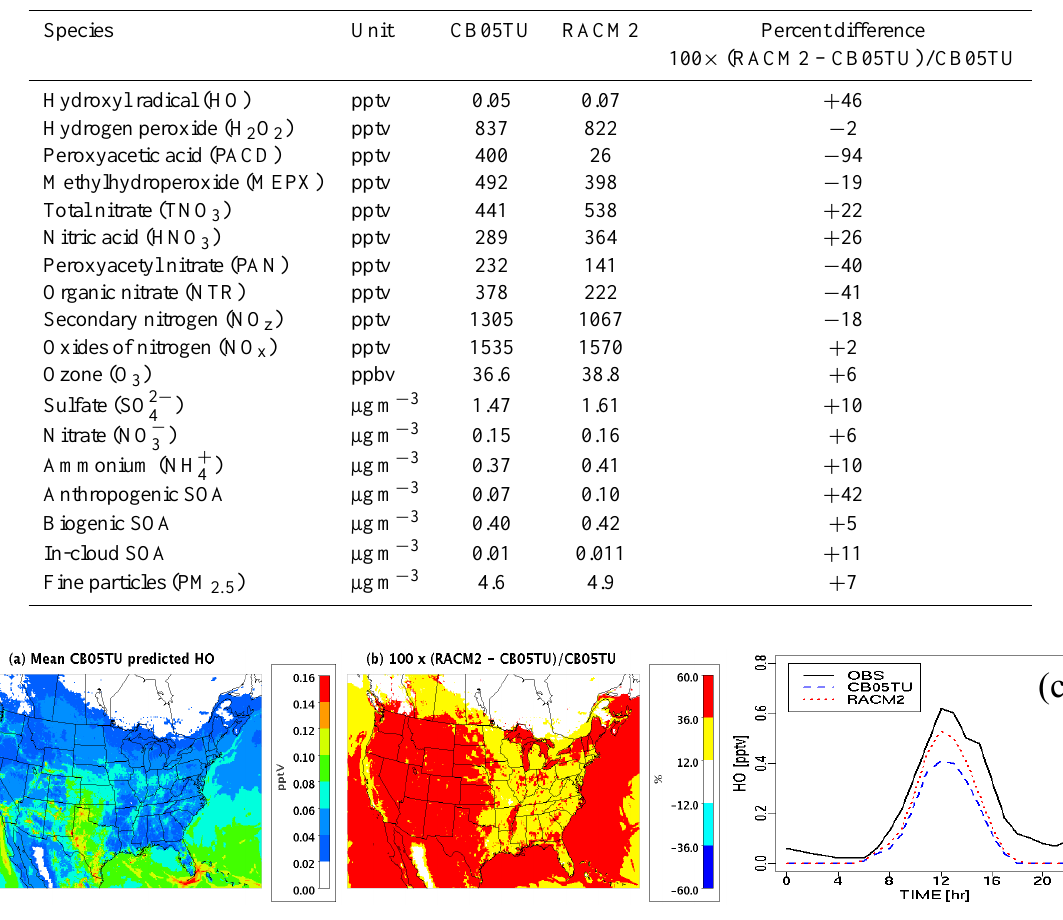
Table 3. A summary of the comparison of CB05TU and RACM2 predicted domain-wide monthly mean values.